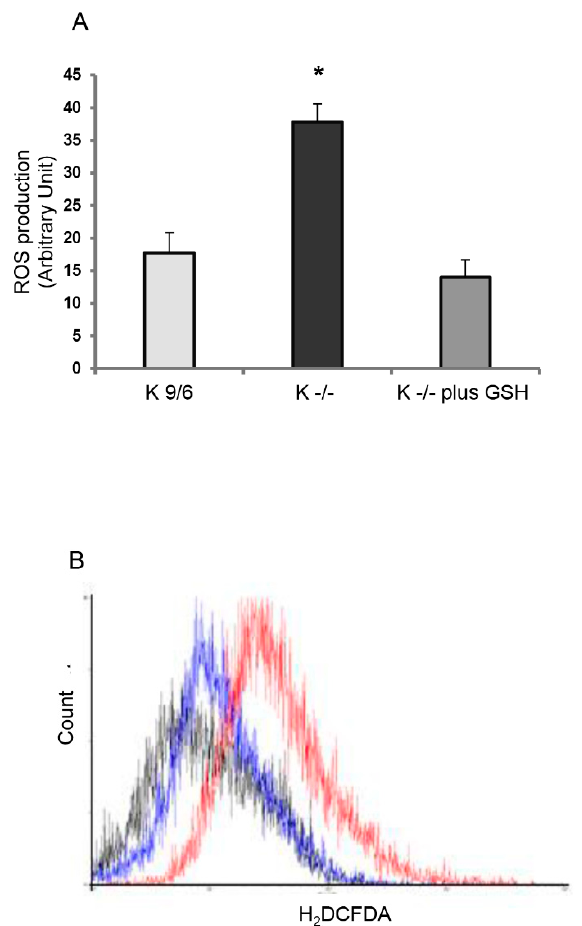
Figure 2. GSH delivery rescues the cellular redox imbalance induced by KRIT1 loss-of-function. ( A ) Measurement of ROS levels in K − / − cells left untreated or treated for 4 h with 5 mM GSH delivered by liposomes. K 9/6 cells were used as control. The cell-permeant carboxy-H 2 DCFDA (C400) probe was used for ROS labeling and measurements were performed by flow cytometry, as described in Materials and Methods. ROS concentrations are reported as fluorescence arbitrary units normalized to the initial mean control values, and represent the mean ± S.D. of three independent experiments. Asterisk indicates significant differences ( p < 0.0001). ( B ) Flow cytometric graph representative of the data reported in (A). Gray line = K 9/6 cells; red line = K − / − cells; blue line = K − / − cells plus GSH.